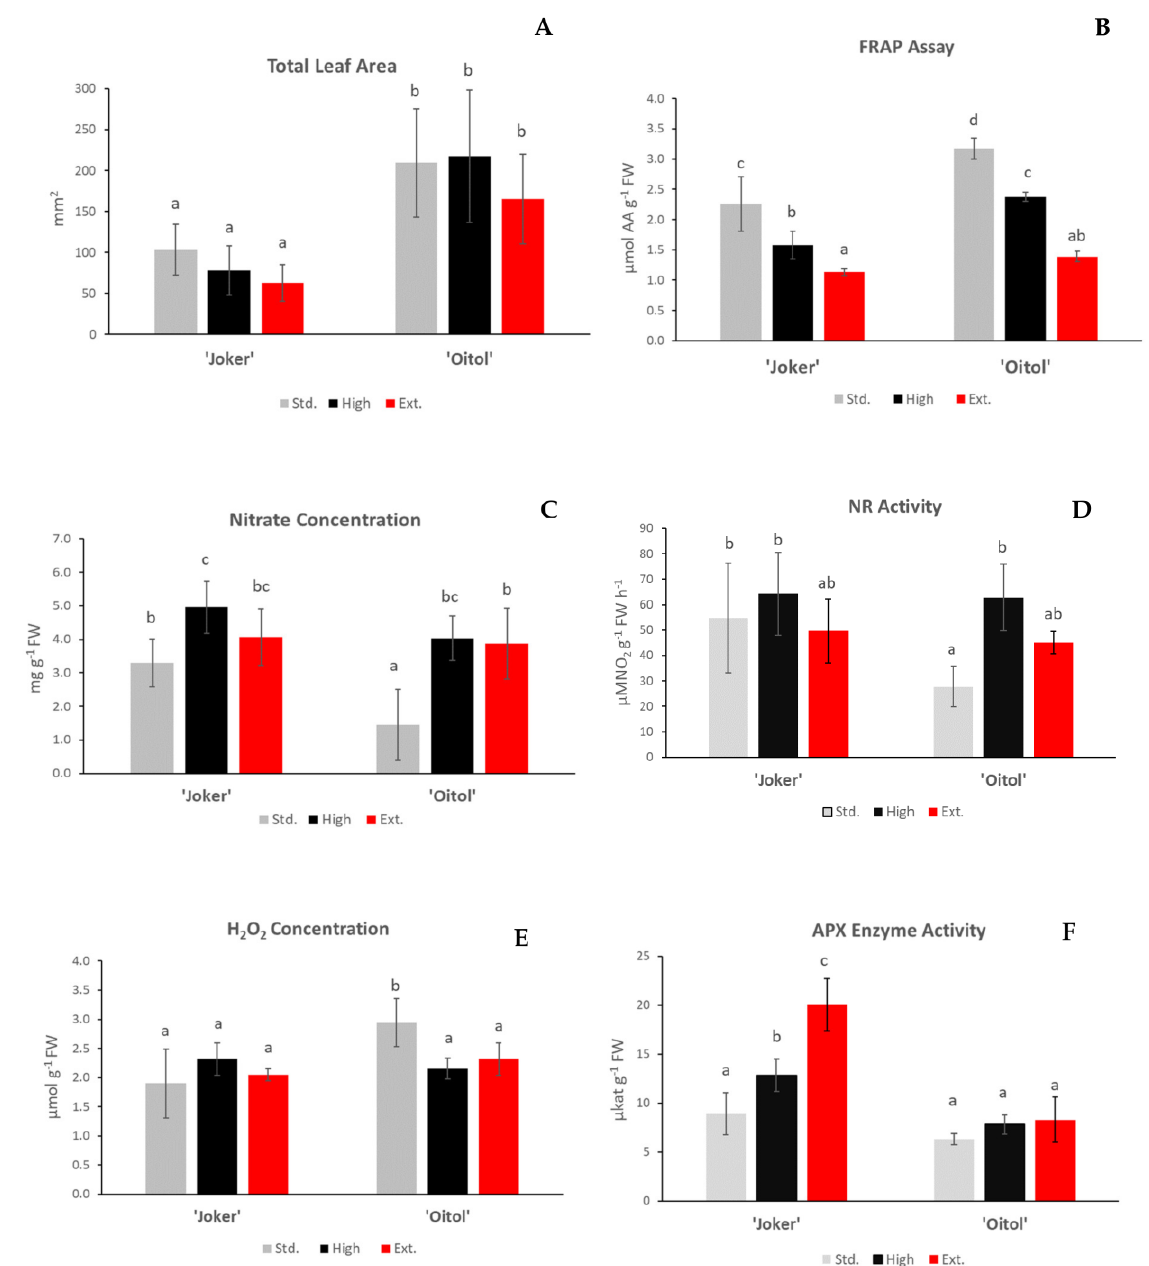
Figure 1. Total leaf area ( A ), Antioxidant capacity ( B ), Nitrate content ( C ), Nitrate reductase activity ( D ), Hydrogen peroxide content ( E ) and APX enzyme activity ( F ) in the leaves of two cucumber hybrid lines treated with different nitrate concentrations. Std.: 4 mM, High: 20 mM and Ext.: 50 mM KNO 3 . Different letters are for significantly different values in accordance with the ANOVA followed by Tukey’s post hoc test ( p < 0.05). Data are the means of at least six replicates, with error bars representing standard